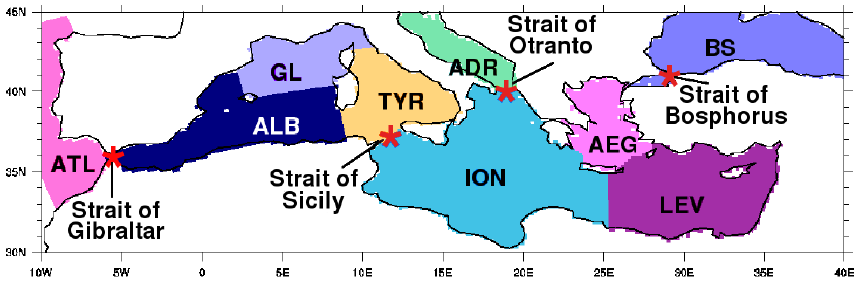
Fig. 2. Sub-basins of the Mediterranean: Gulf of Lion (GL), Alboran Sea (ALB), Tyrrhenian Sea (TYR), Adriatic Sea (ADR), Ionian Sea (ION), Aegean Sea (AEG), Levantine Sea (LEV). The Atlantic box (ATL) and the Black Sea (BS) are shown as well. The main straits are marked with a red